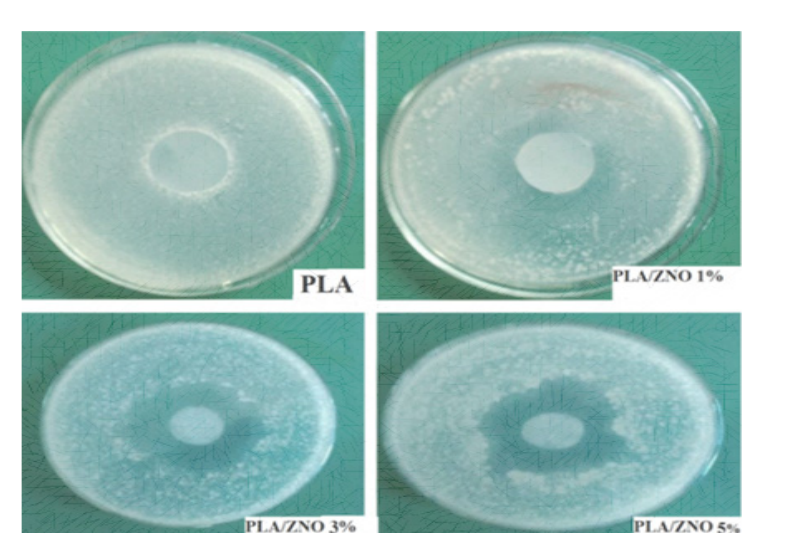
Fig. 1. The inhibitory effect of poly-lactic acids containing nano-zinc oxide E.